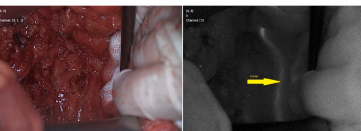
Figure 1. Fluorescent visualization of a ureter during rectal cancer anterior